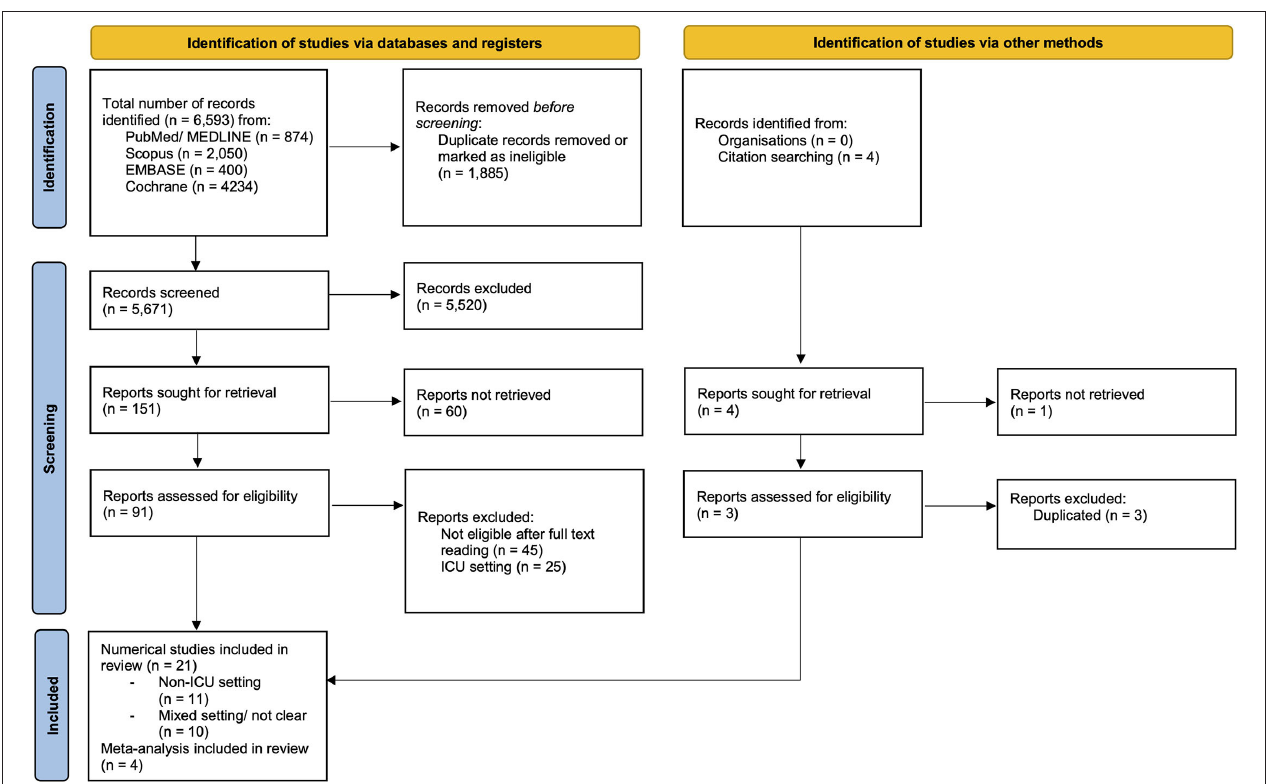
FIGURE 1 | PRISMA 2020 flow diagram for new systematic reviews which include searches of databases, registers, and other sources. From (12) http://www.prisma-